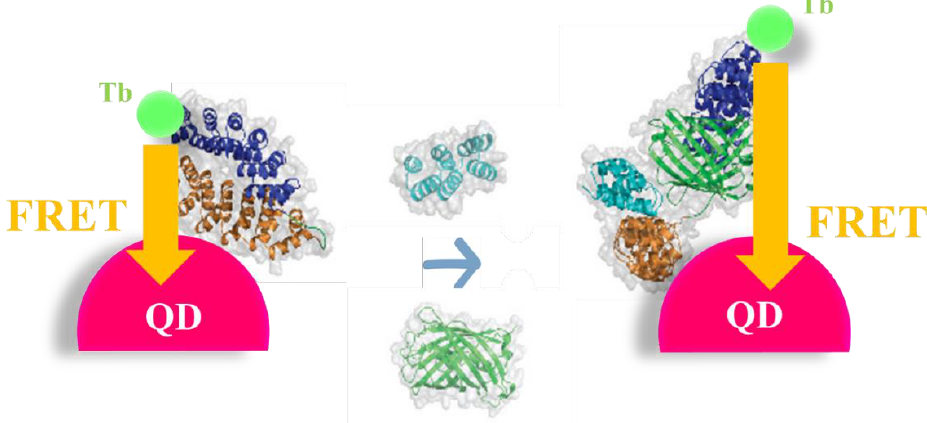
Figure 4. Scheme of the bidomain-based FRET biosensor. Readapted and reprinted with permission from [34] Copyright (2022) American Chemical Society.